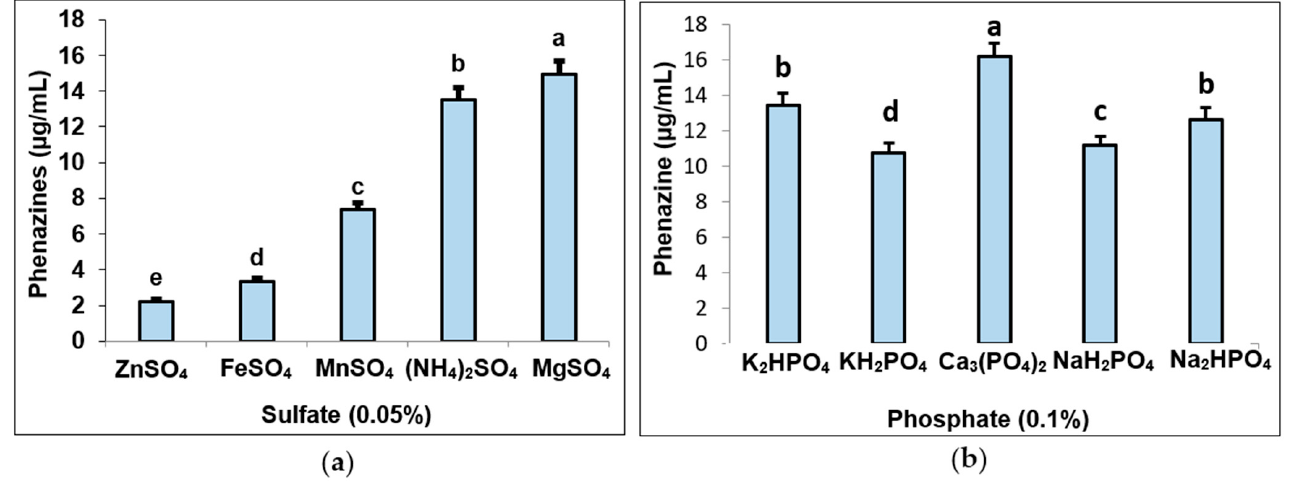
Figure 3. The effect of sulfate ( a ) and phosphate ( b ) salts for phenazine production by Pseudomonas aeruginosa TUN03. Thirty milliliters of culture broth including 1% SPP and respective salt type for each test was fermented at 28 °C for 3 d and shaking at 150 rpm. The data showed that the different letters are significantly different. The LSD values; CV for the test of 0.05% sulfate (0.0731; 0.468512, respectively) and for the test of phosphate 0.1% (0.0982; 0.246744, respectively) are presented.